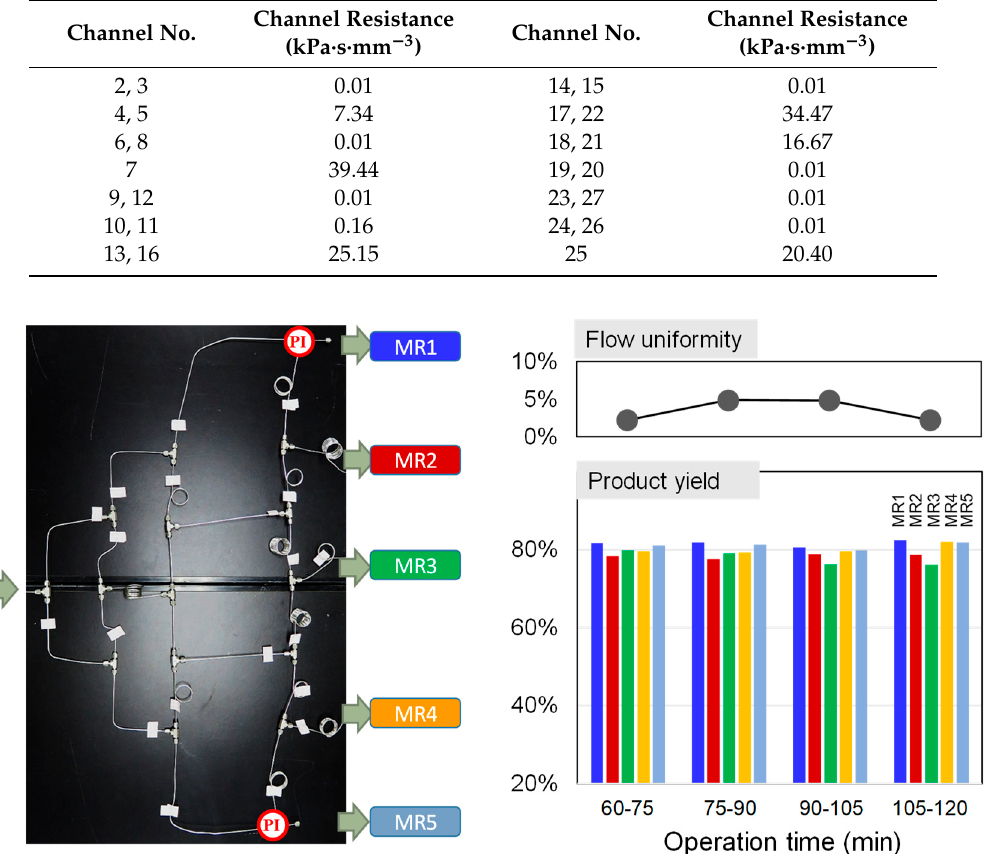
Figure 9. Constructed SRFD (left) and flow uniformity and product yield during the reaction experiment (right).